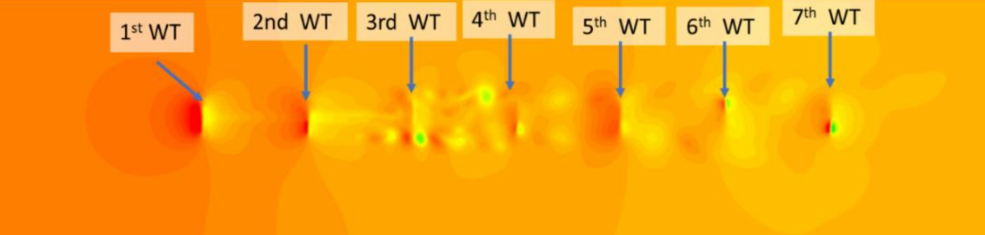
Figure 9. The pressure distribution around a line of wind turbines, with seven turbines at 4.5 diameters distance apart. The induction zone in the front of each turbine is clearly visible.